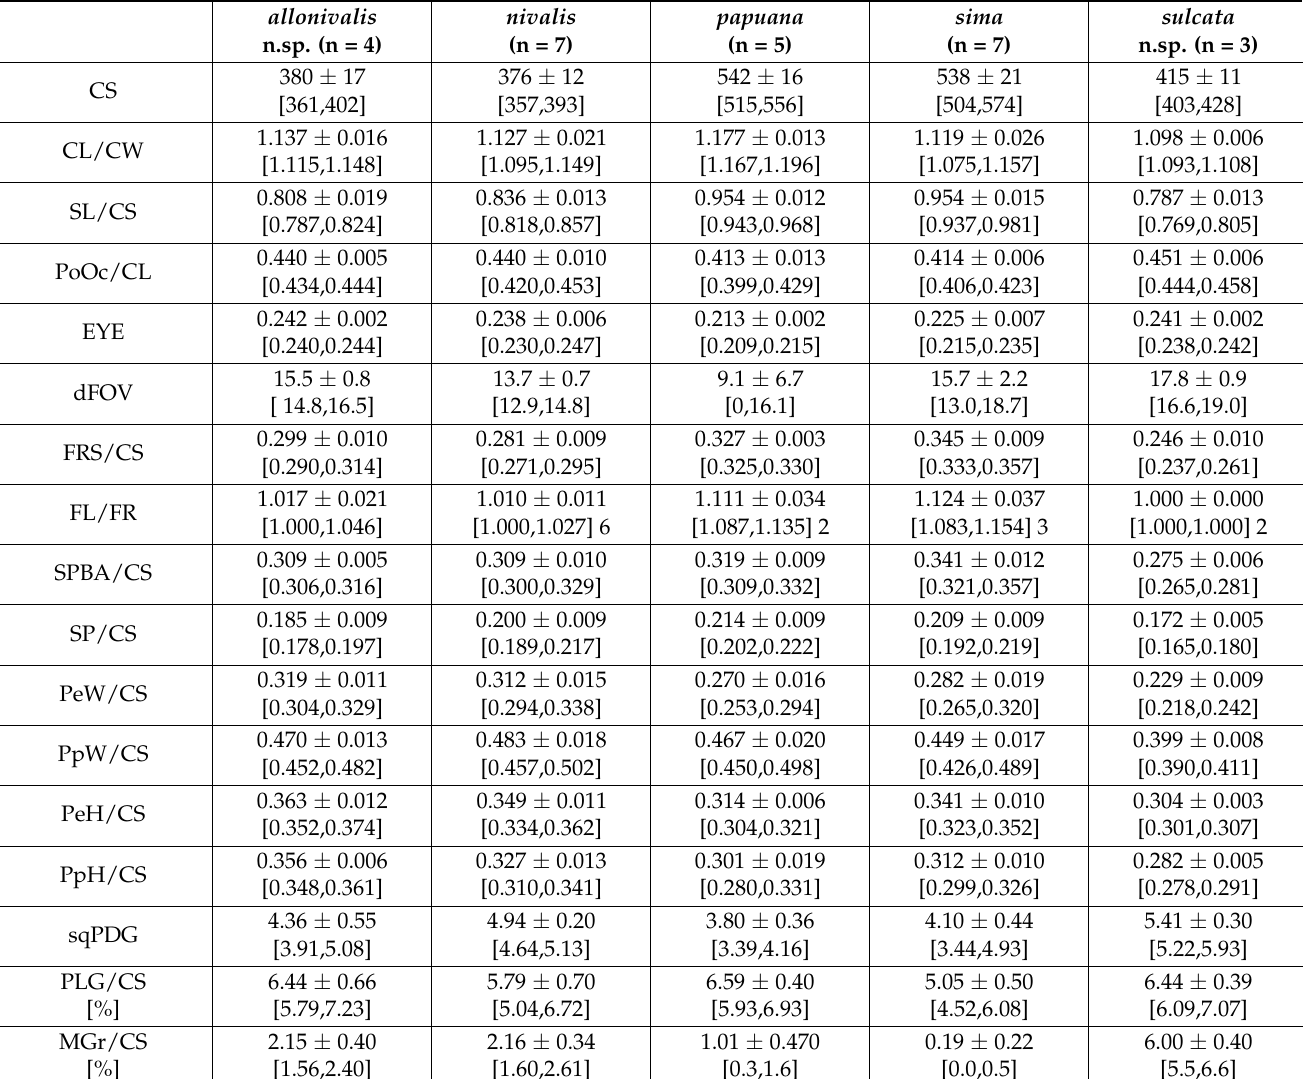
Table 3. Measurements of workers of the Cardiocondyla nivalis , C. sima and C. sulcata groups. Explana- tion of data arrangement as in Table